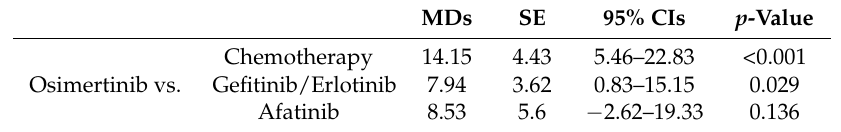
Table 1. Network meta-analysis of PFS: osimertinib vs. chemotherapy, vs. gefitinib or erlotinib, vs. afatinib. MDs